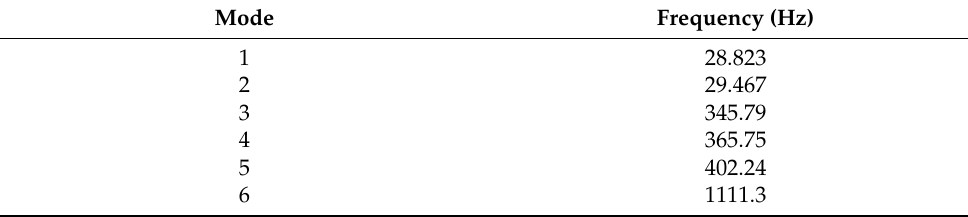
Figure 8. Result of static structural analysis based on walking gait cycle. Table 5. The first 6 modes of implantable lengthening nail’s natural